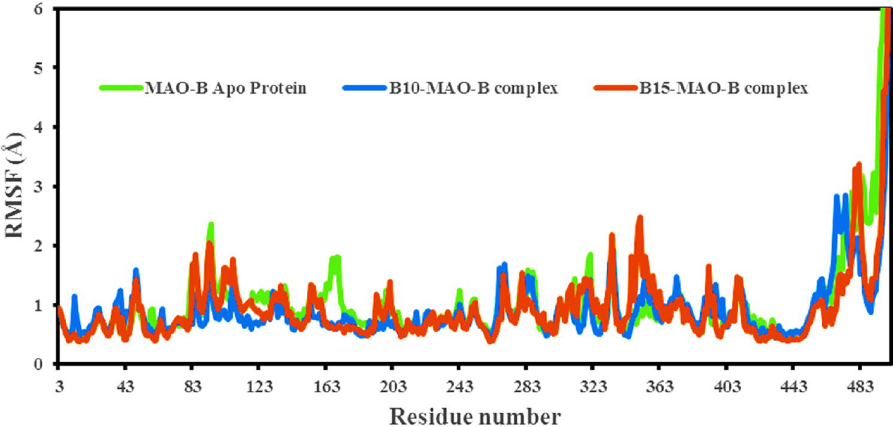
Figure 7. RMSF of the hMAO-B protein backbone in complexes with compound B10 (blue) and B15 (red) during 100 ns